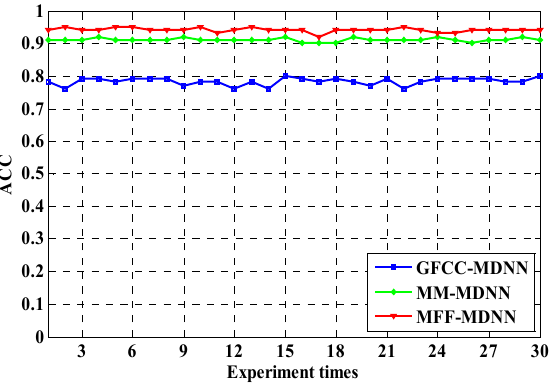
Figure 13. The recognition accuracy of the GFCC-MDNN, the MM-MDNN, and the multi-dimensional fusion features and a modified deep neural network MFF-MDNN.